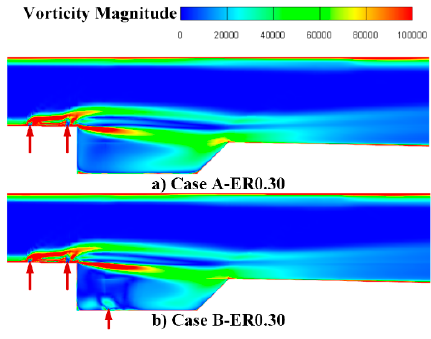
Figure 13. Vorticity magnitude in the cases A-ER0.30 and B-ER0.30.